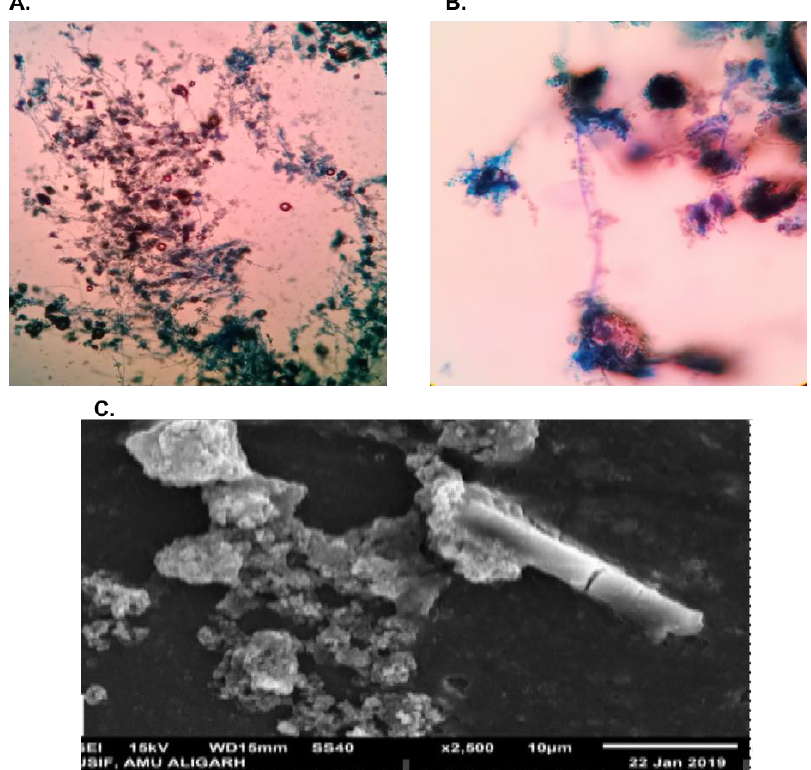
Figure 7. ( A , B ). Light microscope images of A . flavus fungal mycelium treated with AgNPs; ( C ). SEM image showing disturbed fungal mycelium treated with biosynthesised AgNPs.